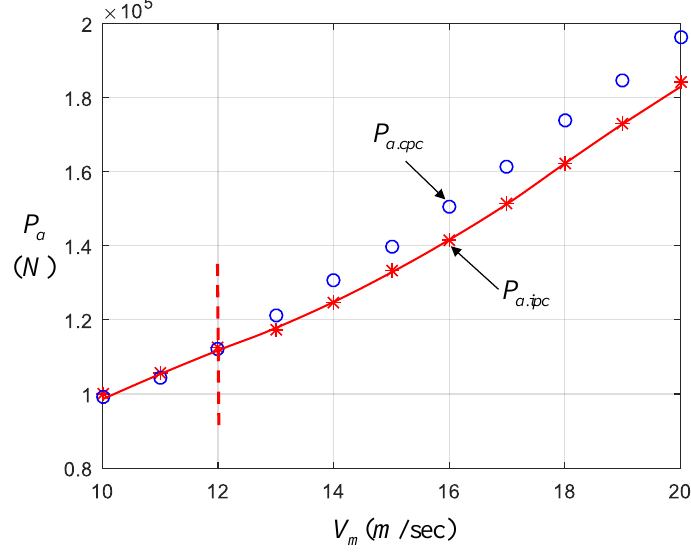
Figure 11. Dynamic equivalent dynamic loads of bearing a P (for individual pitch control, or IPC) and ca P . (for collective pitch control, or CPC) for various wind speeds.